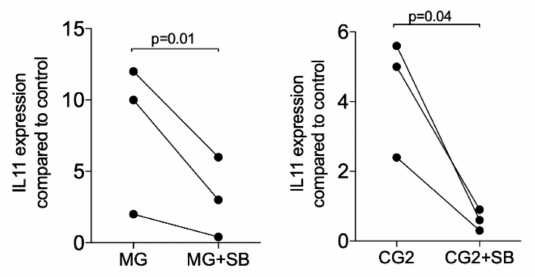
Figure 5. TGF- β receptor I kinase is required to increase IL11 in response to MG and CG2. ® Gingival fibroblasts were exposed to the supernatant of Mucograft (MG) and Collagen Graft 2 (CG2) in the presence or absence of the TGF- β receptor 1 antagonist SB431542 (SB). Reverse transcription PCR analysis for IL11 was performed. Statistical analysis was based on a T-test of paired data. N =